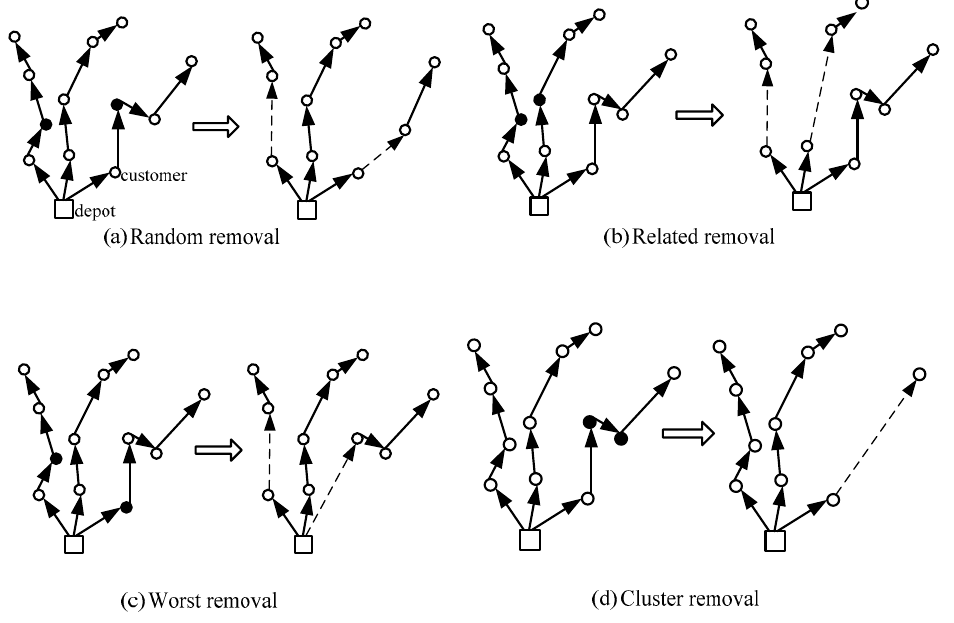
Figure 3. Four removal heuristics.